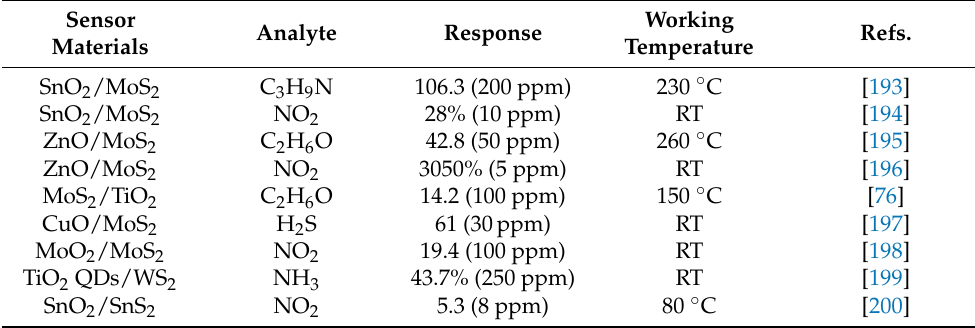
Table 2. Sensors based on MOS modified with TMDs gas sensing